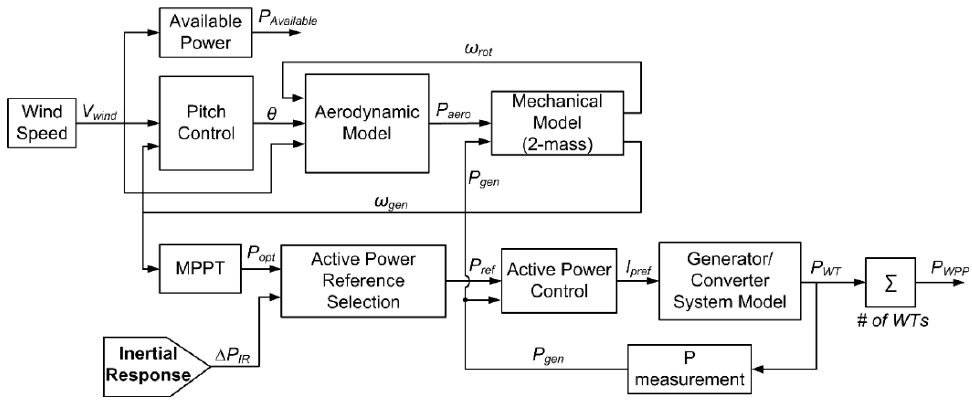
Figure 2. Aggregated wind power plant model for synthetic inertial response studies [23].